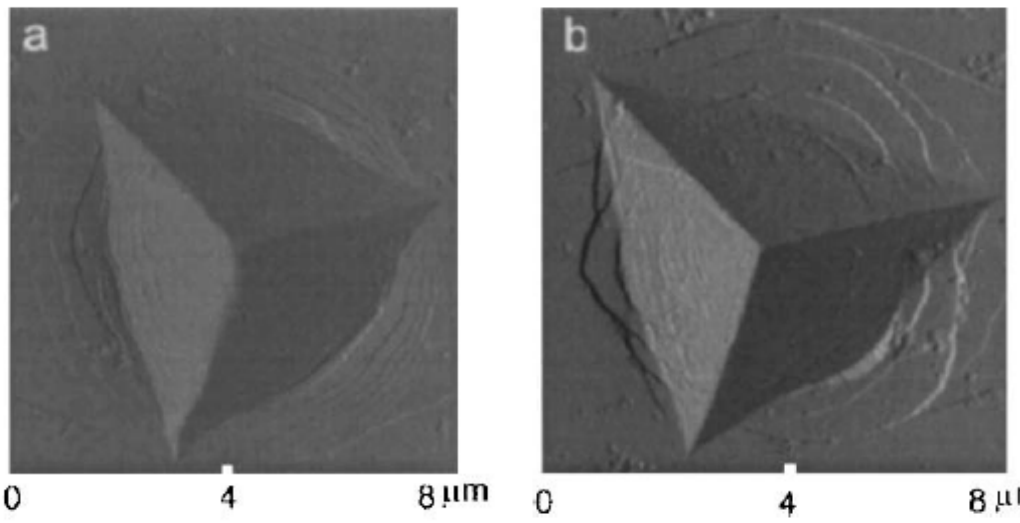
Figure 5. Atomic force microscopy image of Berkovich indents taken at loading rate of ( a ) 100 nm / s and ( b ) 1 nm / s on amorphous AlFeGd ribbon. Reproduced with permission from [30]. Copyrights 2004, Materials Research Society.